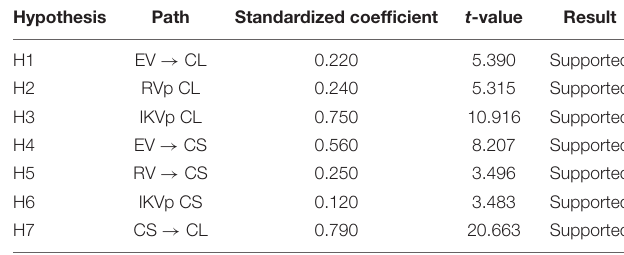
TABLE 8 | Test of